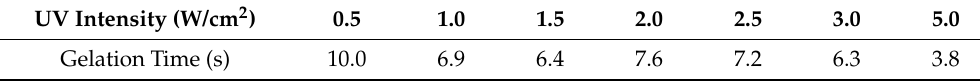
Table 3. Gelation time under different UV intensity (n =